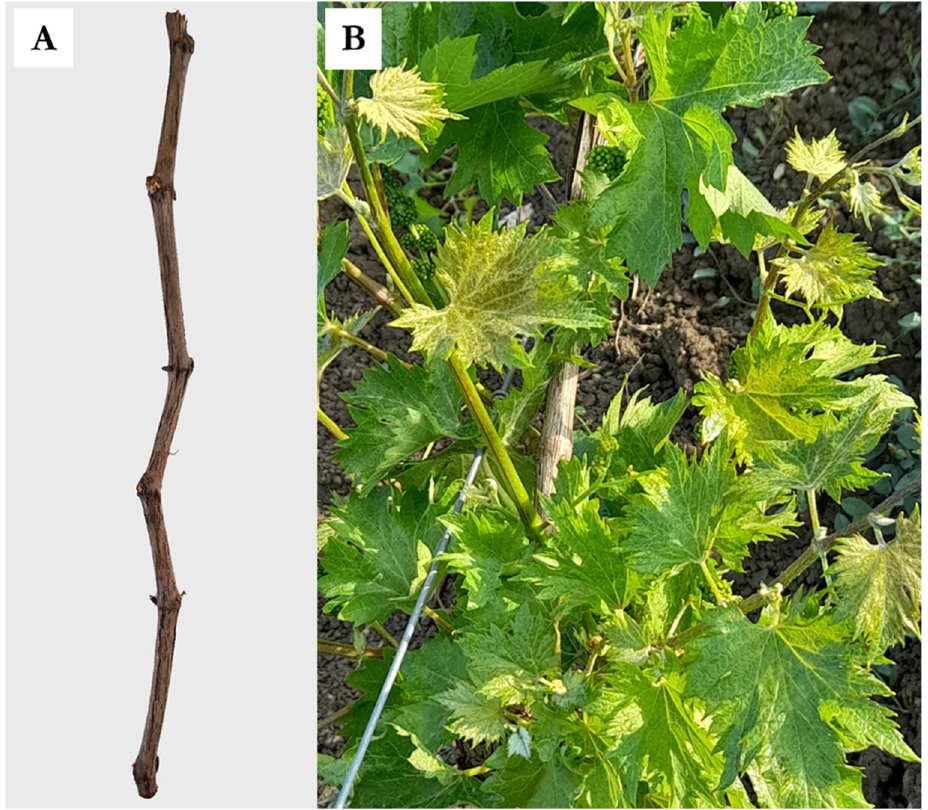
Figure 1. Typical zigzag pattern/shortening of the internodes ( A ) and greenish-yellow mosaic on the leaves ( B ) caused by Grapevine fanleaf virus in Nero d’Avola cultivar. GFLV is transmitted plant-to-plant by the ectoparasitic nematode Xiphinema index [13,27–30].